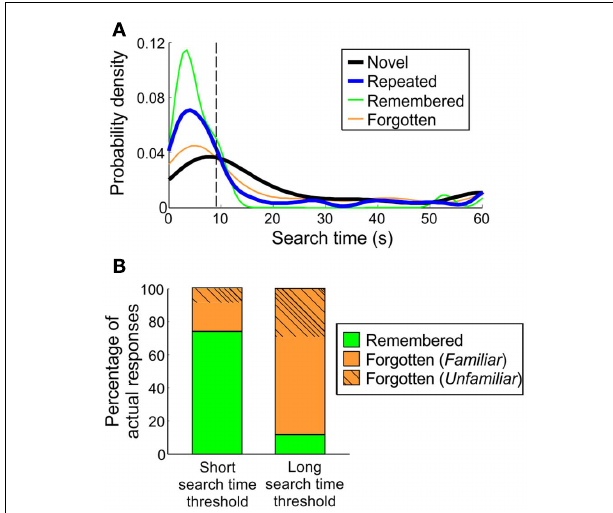
FIGURE 6 | Classification of remembered trials in humans. (A) Search time probability densities of a representative human participant. Search time thresholds are derived from the inflection point of the repeated-trial distribution’s initial “mode.” For the participant shown here, the threshold was 9.33s. (B) Overall accuracy of identifying remembered or forgotten targets, based on short search time threshold (individual inflection points) and long search time threshold